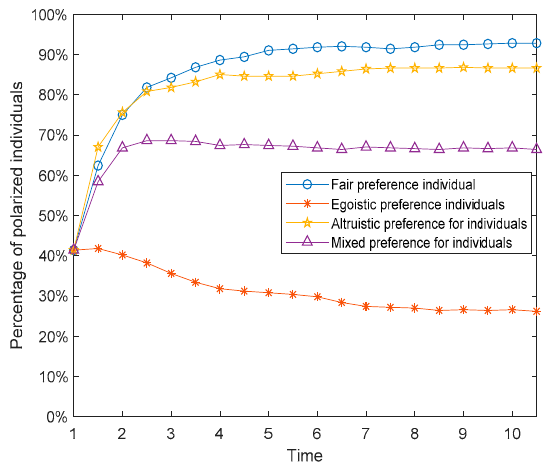
Figure 11. Distributions of intimacy degree.